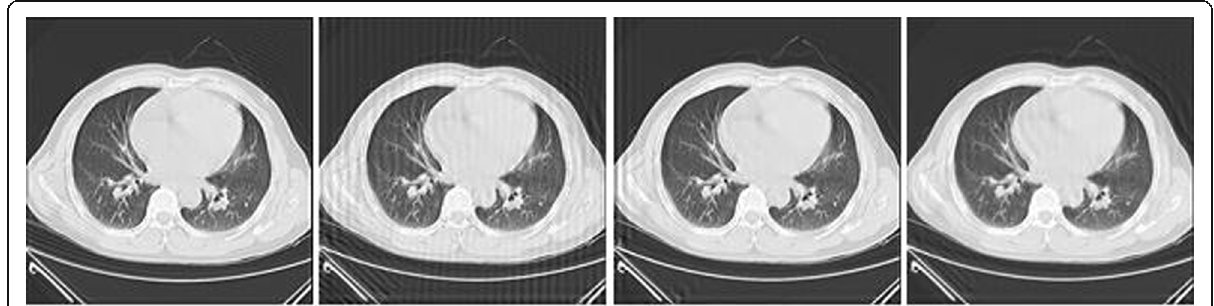
Fig. 4 Comparison of reconstructed images with different reconstruction methods (SNR = 40